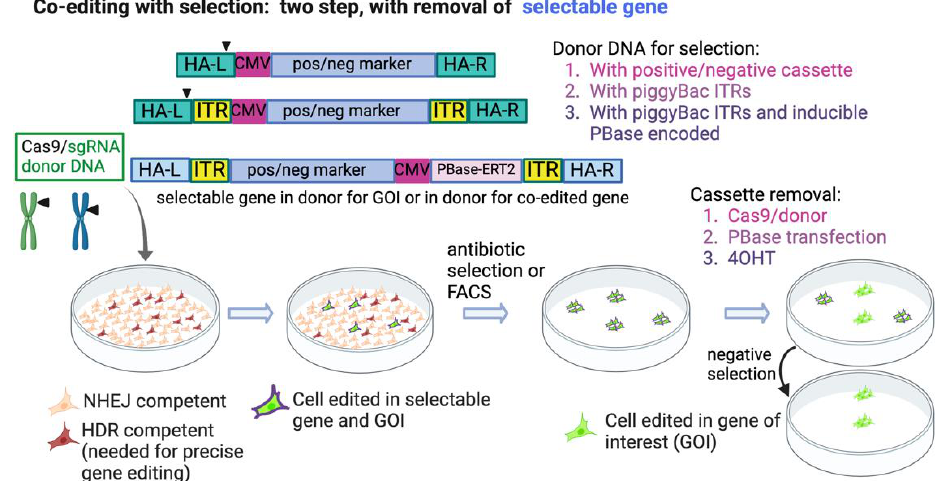
Figure 4. Two-step scarless editing with removal of the selectable gene. This figure is based on strategies presented in references [56,60,62–65,67], although the precise constructs are not fully reproduced, and the depictions are not to scale. The cassettes encode positive and negative selectable genes, depicted here in a general scheme driven by a CMV promoter. The selectable cassettes are contained within the donor DNA for editing the GOI or are included in a donor DNA for co-editing a locus independent of the GOI. HA-L, HA-R; left and right homology arms, respectively. ITR; inverted terminal repeats for later removal of cassette via piggyBac transposase. PBase-ERT2; PBase fused to modified ERT2 for later induction by tamoxifen (4OHT). Created with BioRender.com.